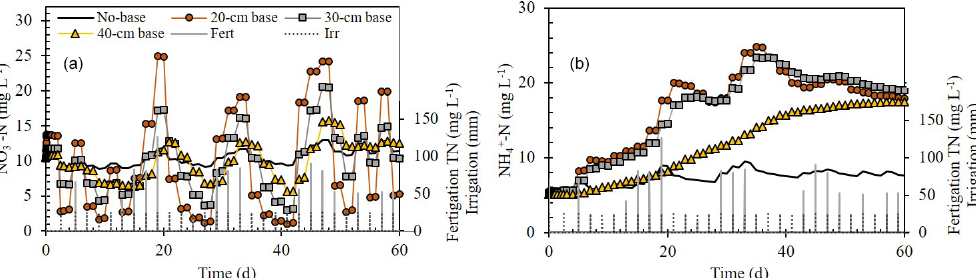
-N and NH + -N concentrations in the top soil (0–10cm) under bases of variable 3 4